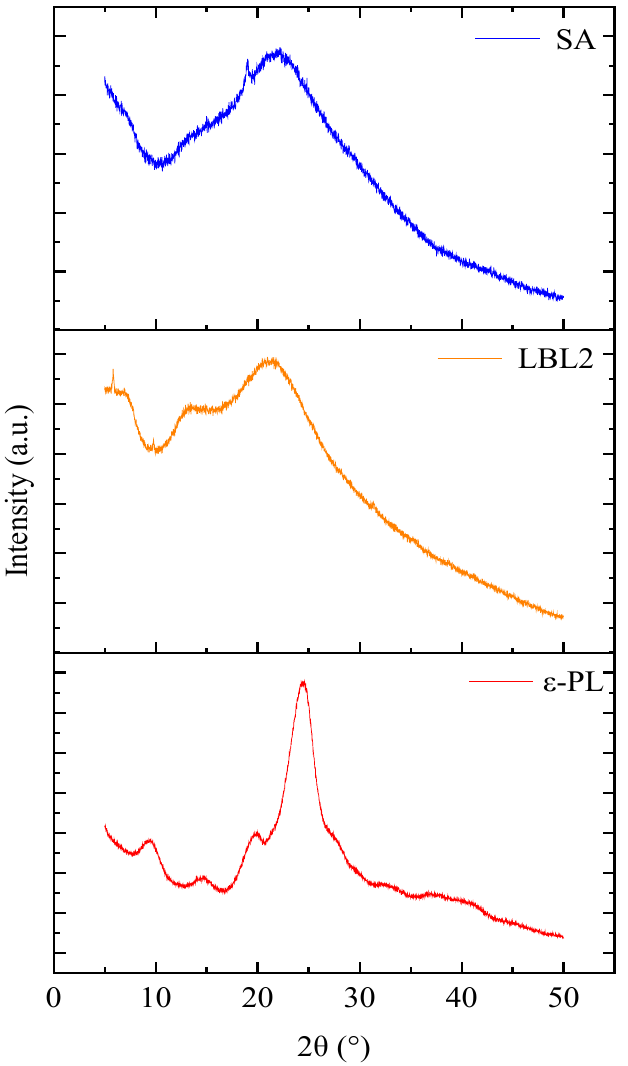
Figure 11. XRD of pure sodium alginate (SA), pure ε - polylysine (ε -PL), and LBL2 films.